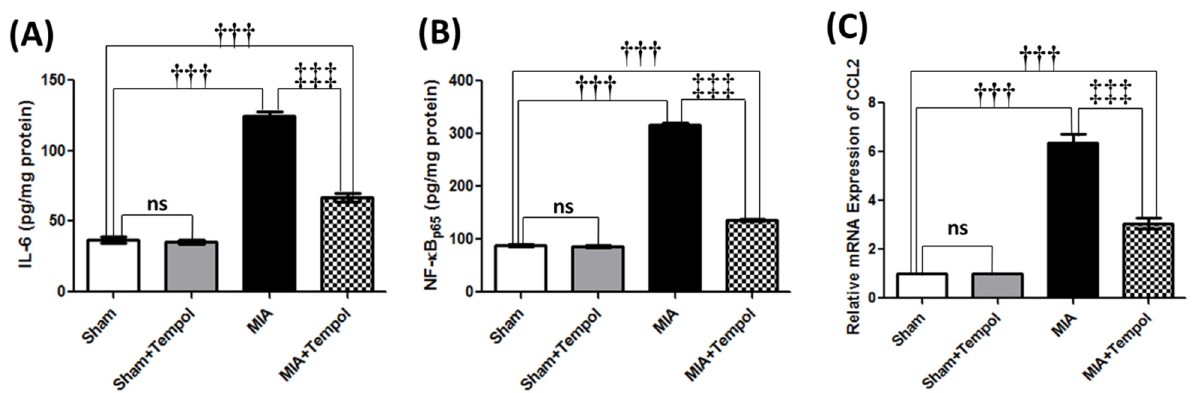
Figure 6. Effect of Tempol on the catabolic inflammatory and pain mediators on osteoarthiritic rats. Rats were subjected to a single intra-articular injection of 3 mg MIA/50 µ L saline in their right knees, and then tempol was administered starting from the 7th day of the experiment in a dose of (100 mg/kg/day) by oral gavage for 21 consecutive days. Values of ( A ) Tissue contents of Interleukin-6 (IL-6), ( B ) Tissue contents of nuclear factor-kappa B (NF- κ B p65 ), and ( C ) The mRNA expression of chemotactic cytokine ligand 2 (CCL2), are expressed as mean ± SD ( n = 6). Statistical analysis was carried out using one-way ANOVA followed by Tukey’s multiple comparison test. ††† p < 0.001 vs. the sham group, and ‡‡‡ p < 0.001 vs. MIA group.